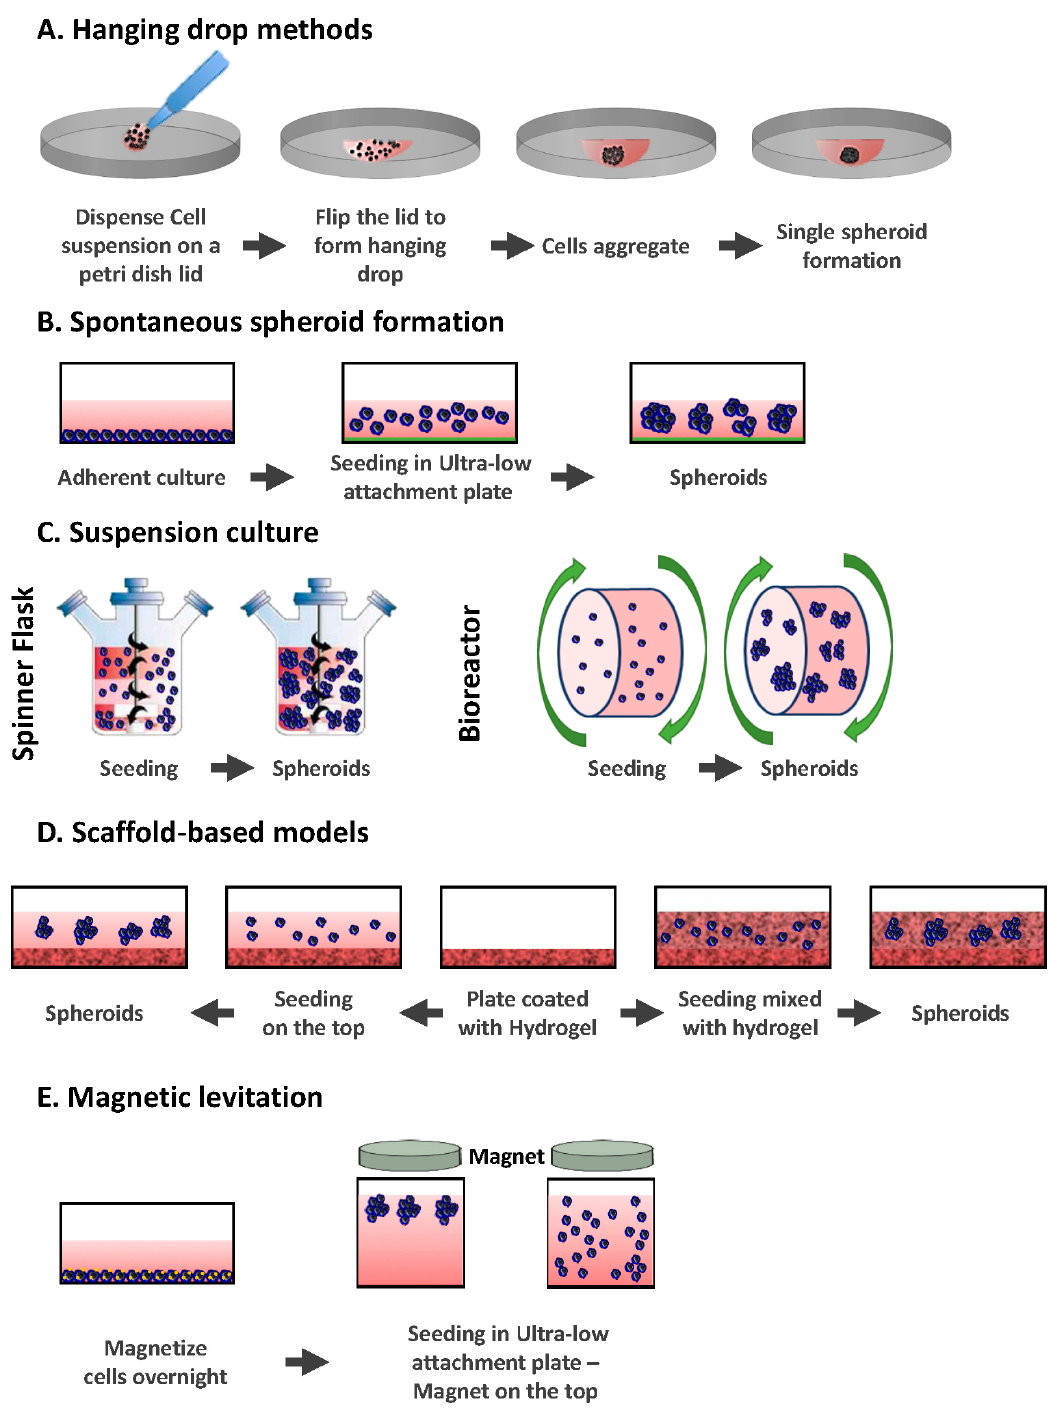
Figure 1. Common 3D techniques used for the creation of spheroids. ( A ) Hanging drop methods. Cells are deposited on a petri dish lid, which is flipped over a petri dish containing PBS; ( B ) ultra low attachment plates. Cells are seeded in an ultra-low attachment plate which prevents them from adhering; ( C ) suspension cultures. Cells are placed in spinner flasks (left) or bioreactors (right) and put under gravitational forces; ( D ) scaffold based-models. Cells are either seeded on the top of a hydrogel (left) or embedded in it (right); ( E ) magnetic levitation. Cells are magnetized in culture and attracted to a magnet located on the top